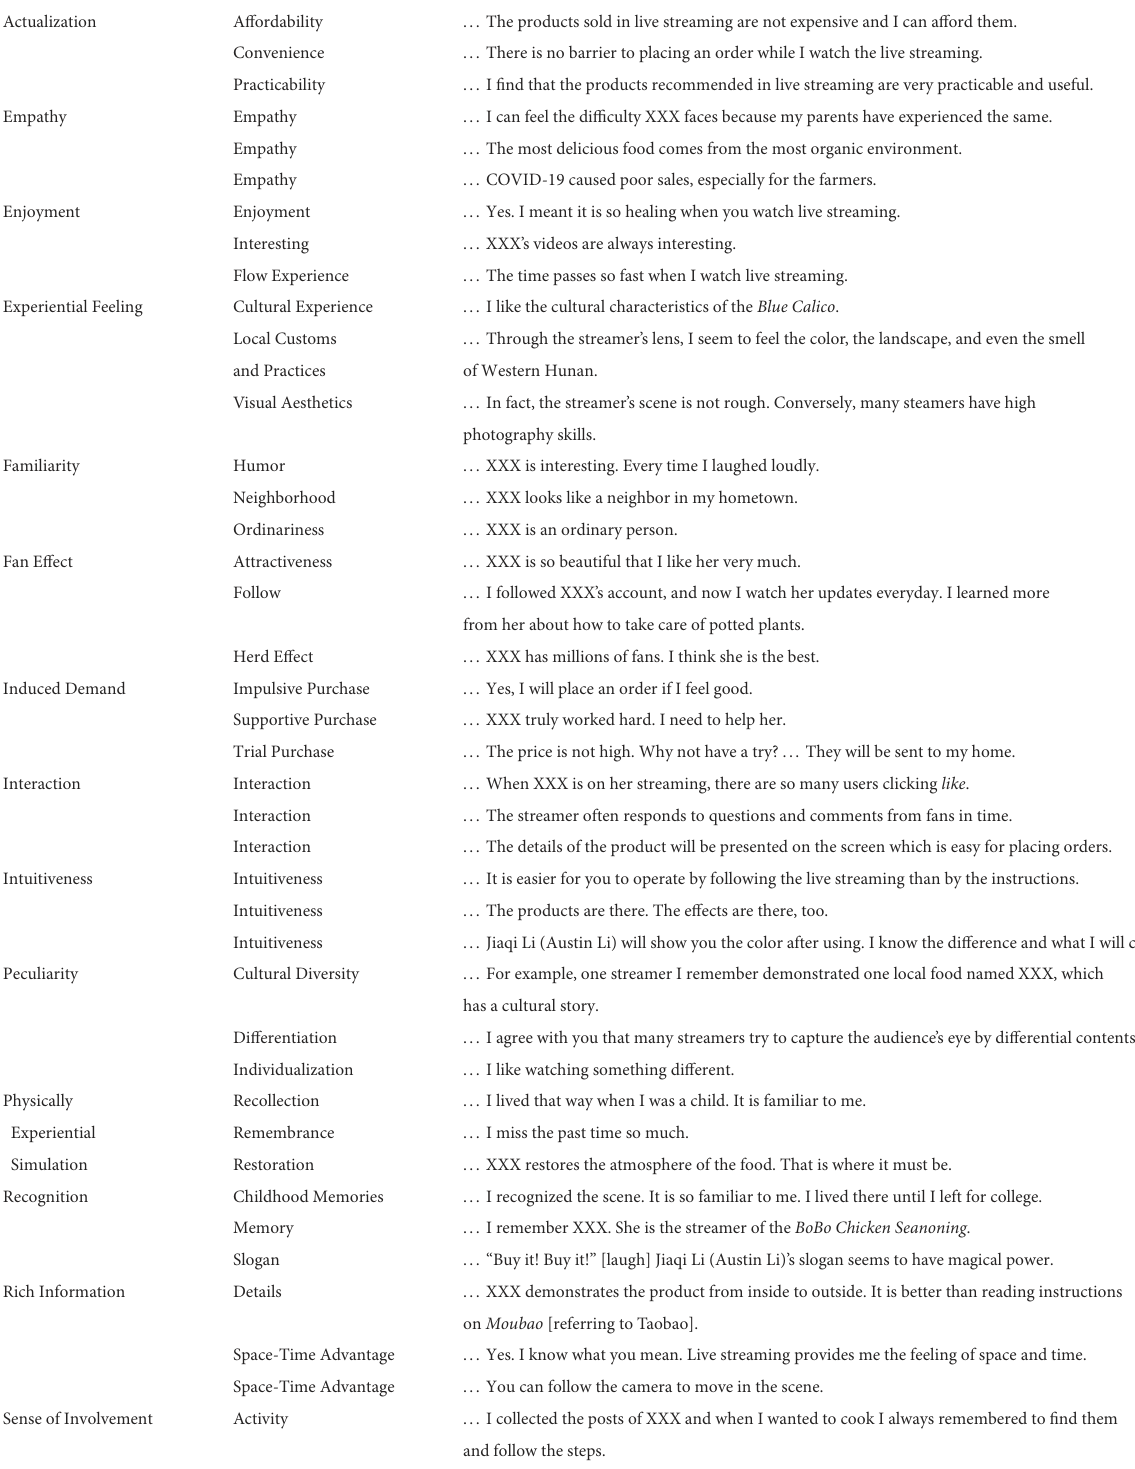
TABLE 2 Examples of 21 categories identified by open coding (in alphabetical order).